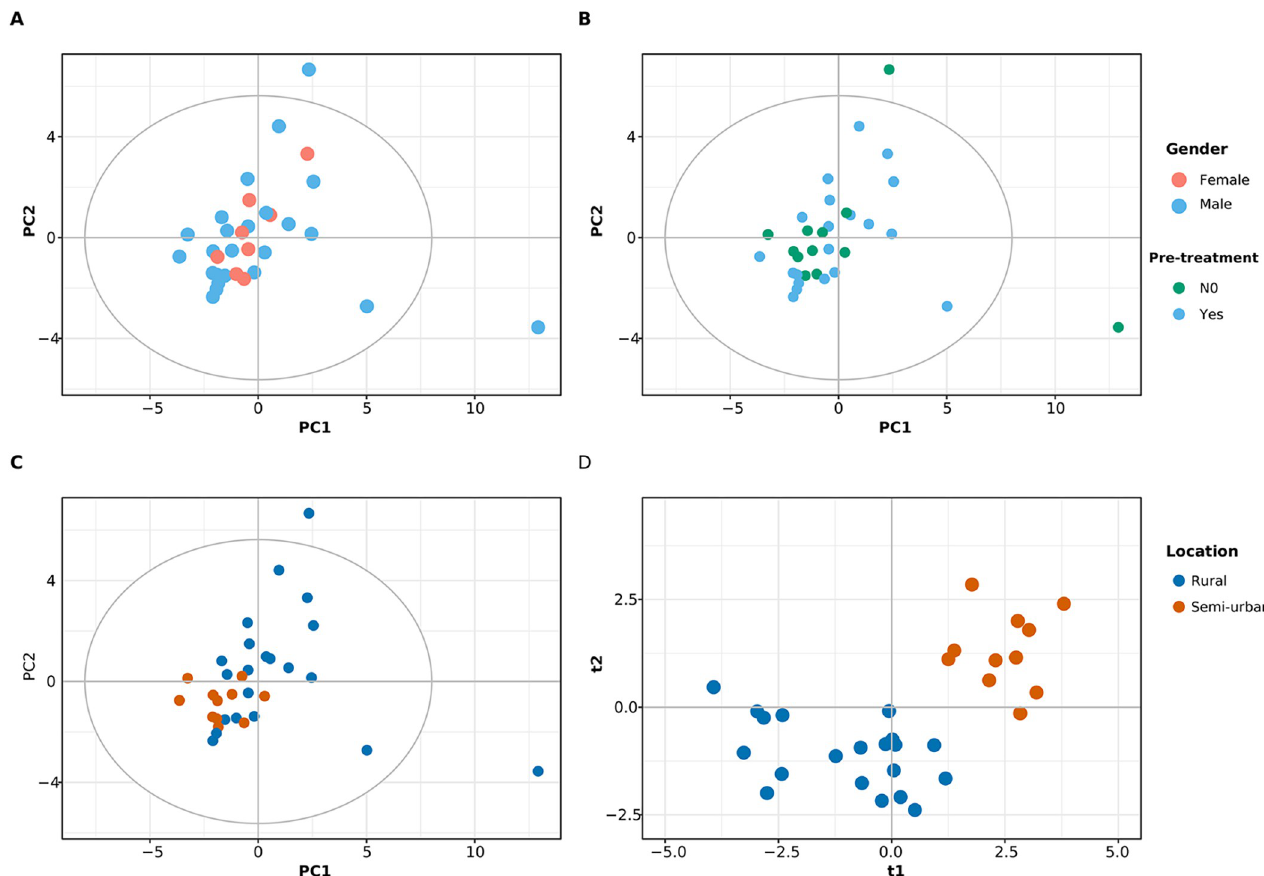
Fig 2. Exploratory analysis of the urine samples of volunteers at baseline. A, B and C show the score plots of PCA model according to sex (male and female), anthelmintic pre-treatment (yes or no) and area of residence (location = rural or semi-urban) respectively. PCA model built for the two first component cover 26% of the variance and 6 components were required to cover 50% of the variance. D- is a cross-validated score plot of 2 class PLS-DA model with location as class identity. Model metrics: R2X = 0.232, R2Y = 0.81, Q2 =